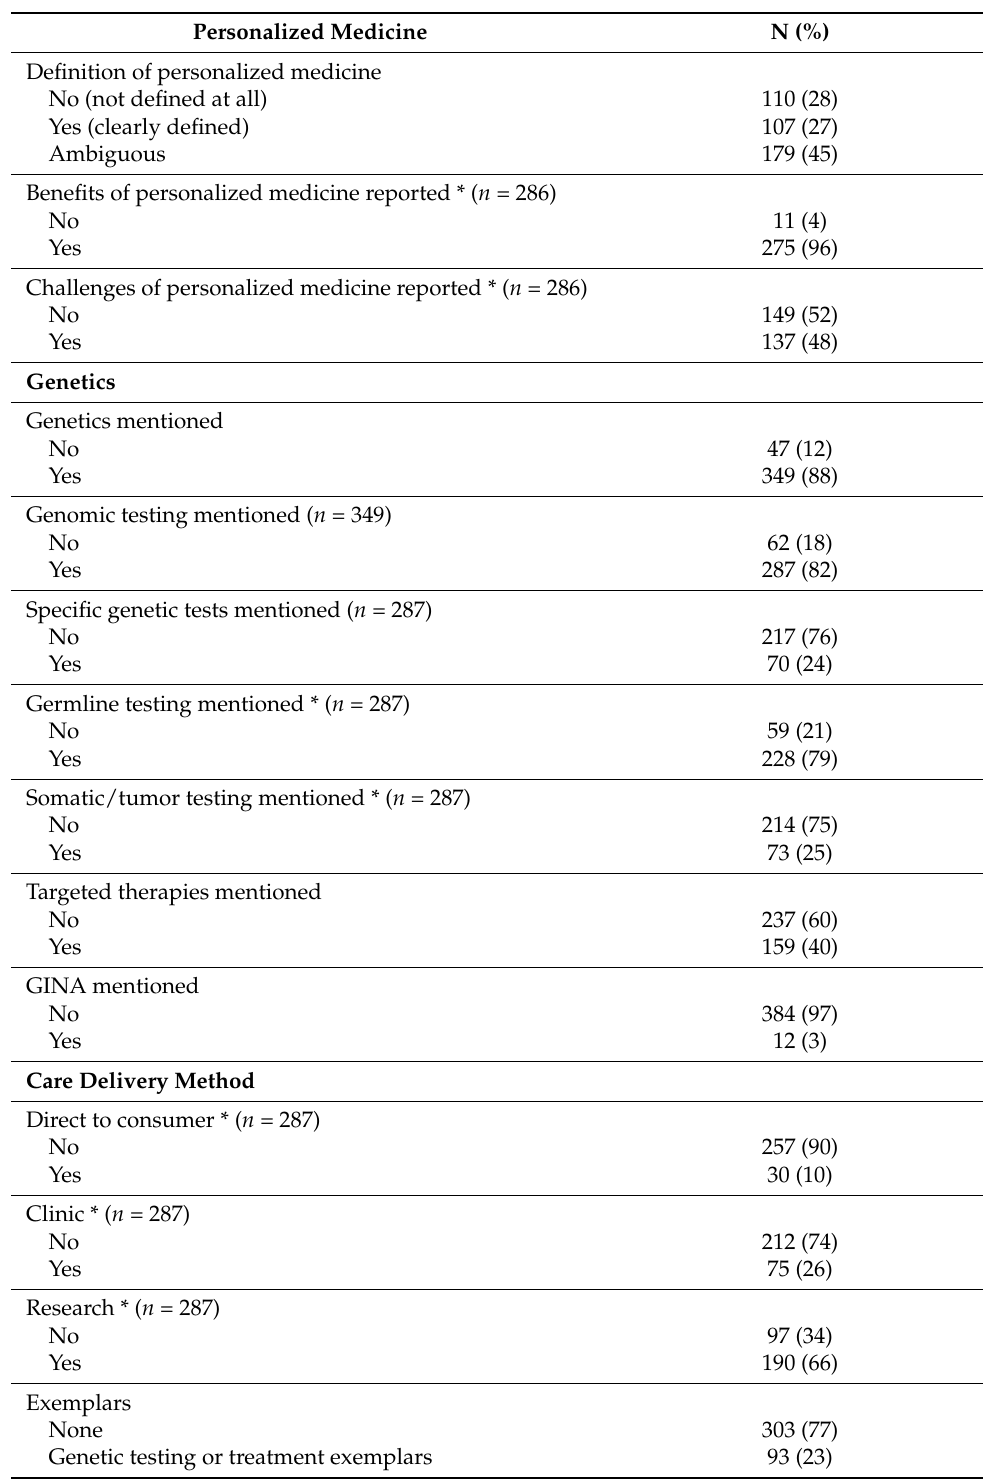
Table 1. Content of media reports on personalized